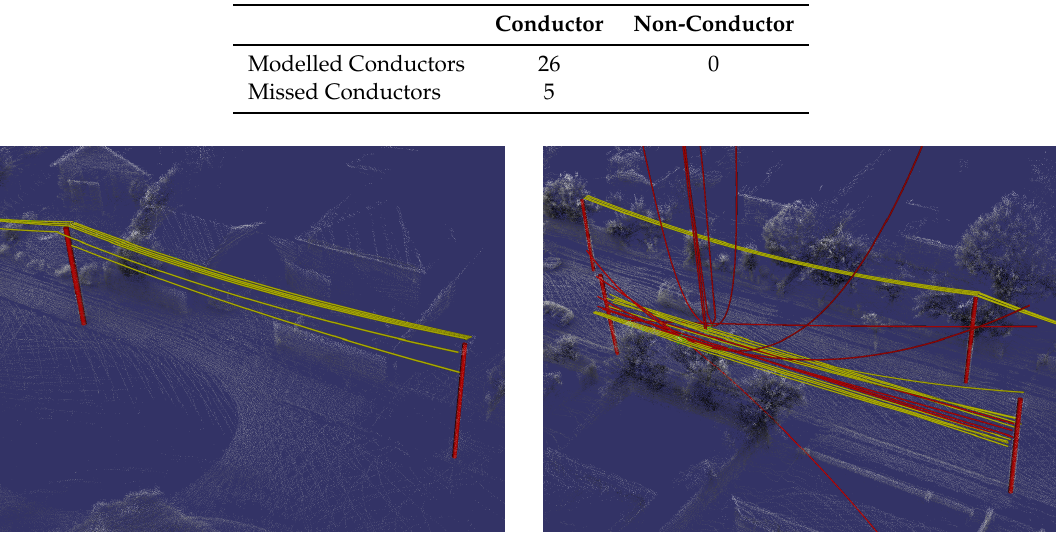
Table 9. Final output on Hounslow dataset using 2-Dimensional Mean Shift Clustering with a bandwidth of 4 cm.